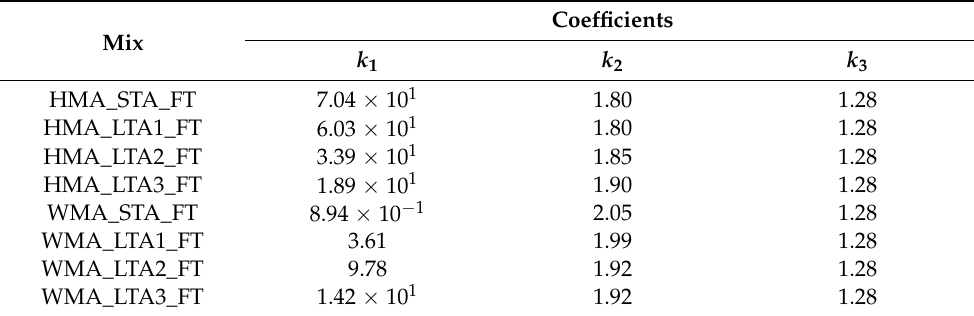
Table 8. Fatigue cracking prediction model coefficients of HMA and WMA mixtures after moisture damage for each stage of